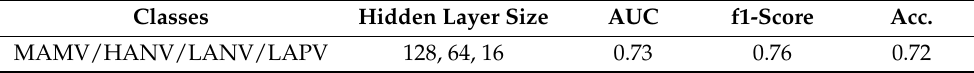
Table 11. Synchronous EA and EV classification